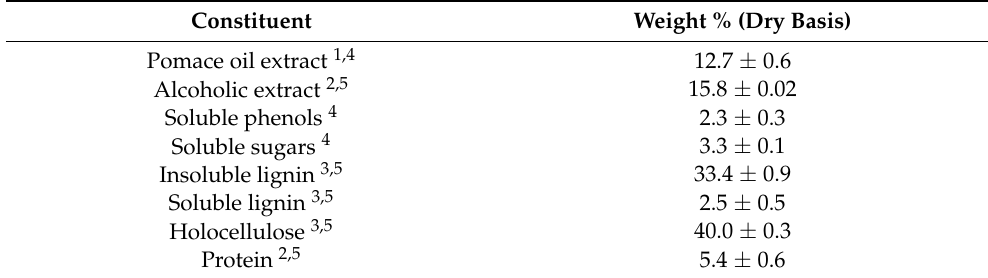
Table 2. Macro-organic constituents of wet pomace.